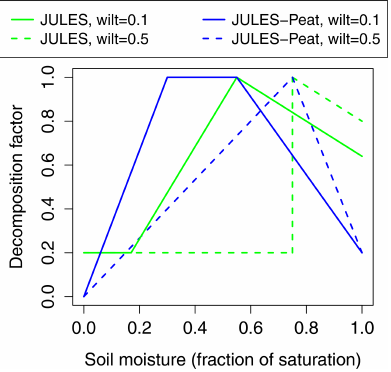
Figure 1. Original (green) and updated (blue) function of moisture used to determine soil respiration ( F θ ; Eq.